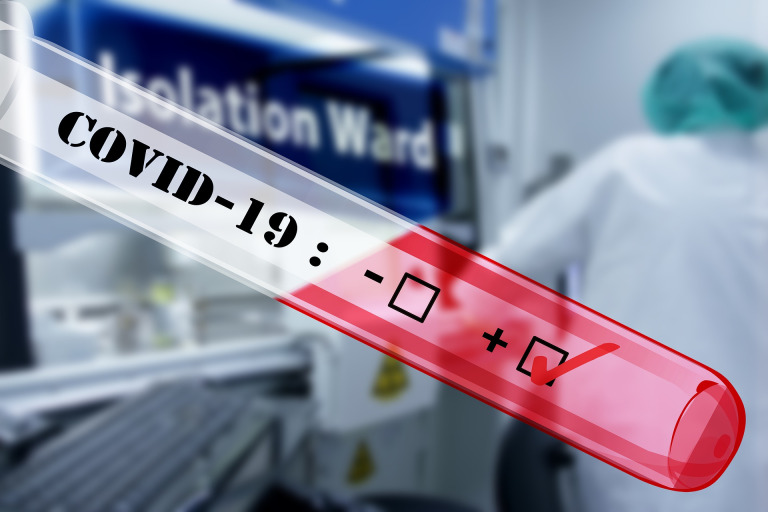
Photo: Image by Gerd Altmann from Pixabay.